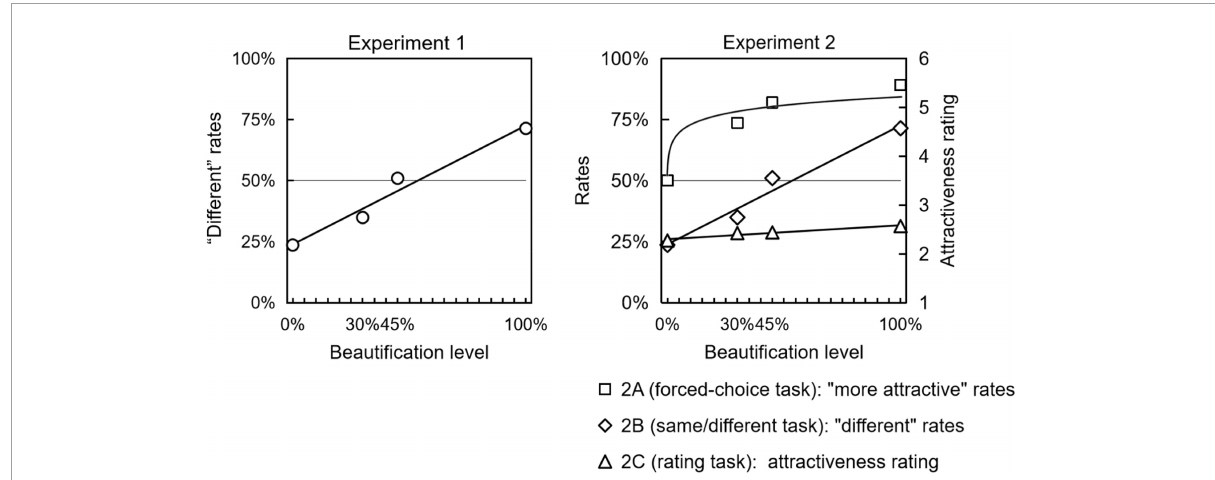
FIGURE6 Detecting facial physical change in Experiment 1 and perceiving facial attractiveness change in Experiment